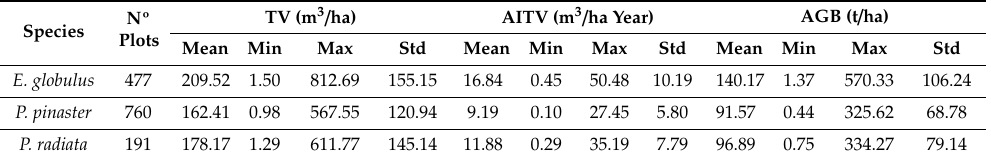
Table 1. Descriptive statistics of total volume (TV), annual increase in total volume (AITV) and total aboveground biomass (AGB), extracted from the SNFI-4 plots with the dominant species equal to or greater than 80% of the total basal area of the final plots used after the harmonization procedure.